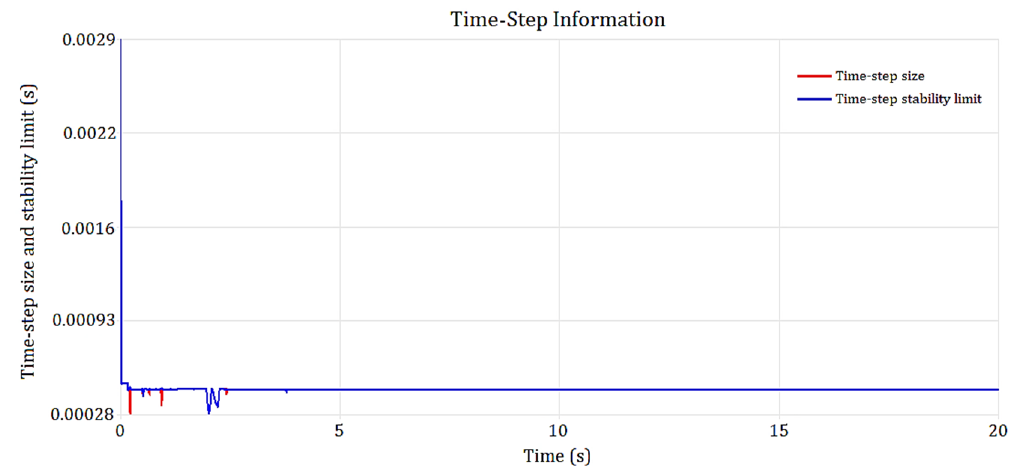
Figure 21. The convergence of the numerical modeling solution.